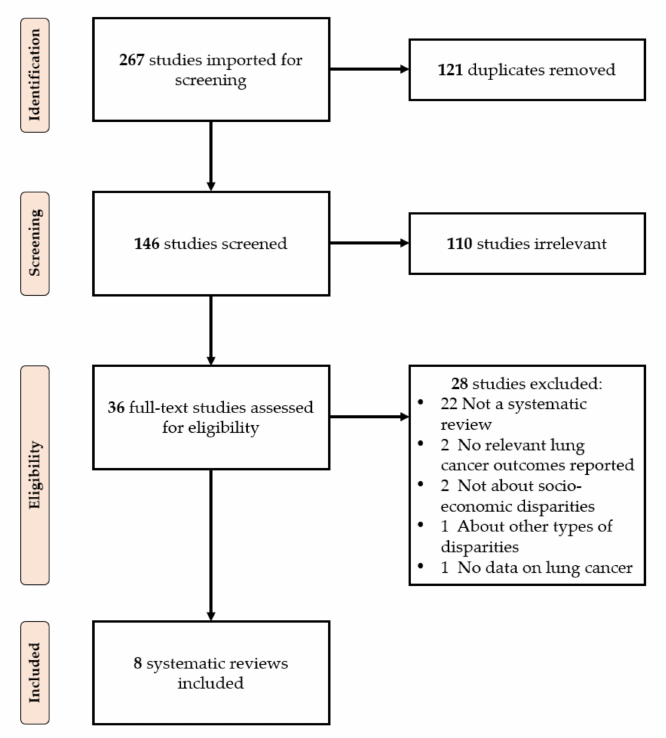
Figure 1. PRISMA flowchart of the review selection